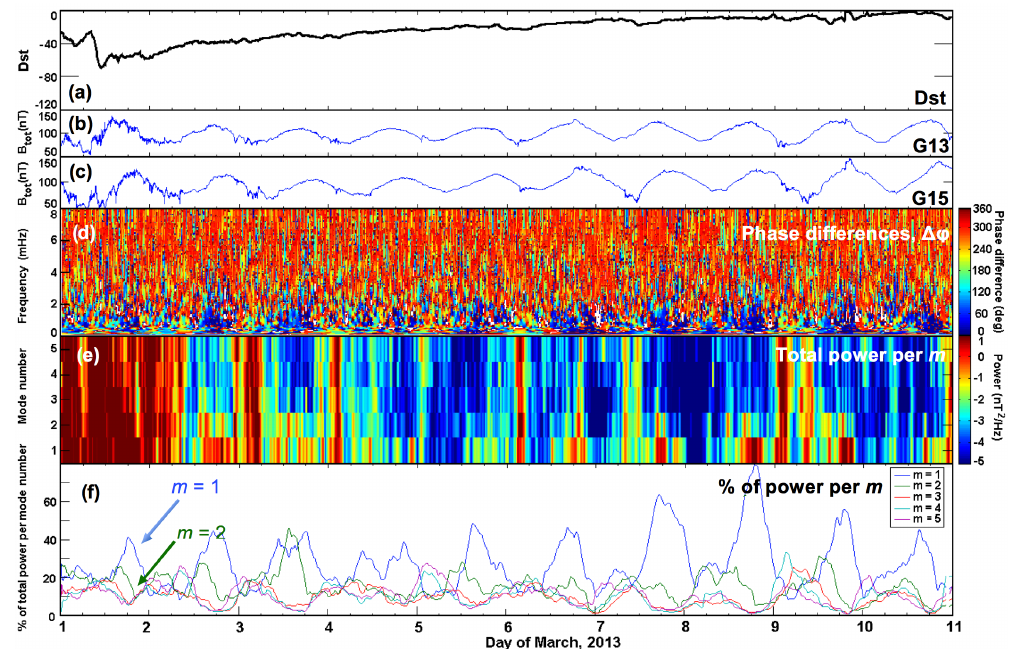
Figure 2. (a) Dst index during 1–11 March 2013; (b) GOES-13 and (c) GOES-15 total magnetic field; (d) calculations of the cross- spectrogram phase differences between the two GOES time series as a function of frequency and time; (e) power per m number calculations using cross-spectrogram calculations between GOES-13 and GOES-15; (f) fraction of the total power in each of the wavenumbers m = 1 to